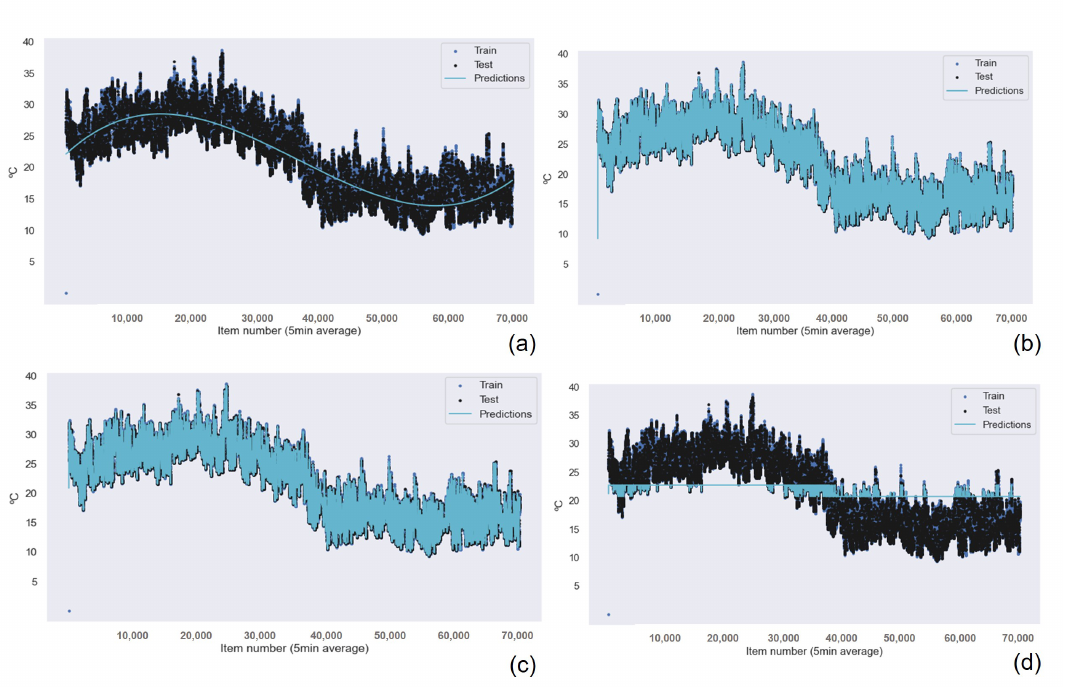
Figure A8. Temperature results for ( a ) Linear Regression ( b ) Random Forest Regression ( c ) KNN and ( d ) Support Vector